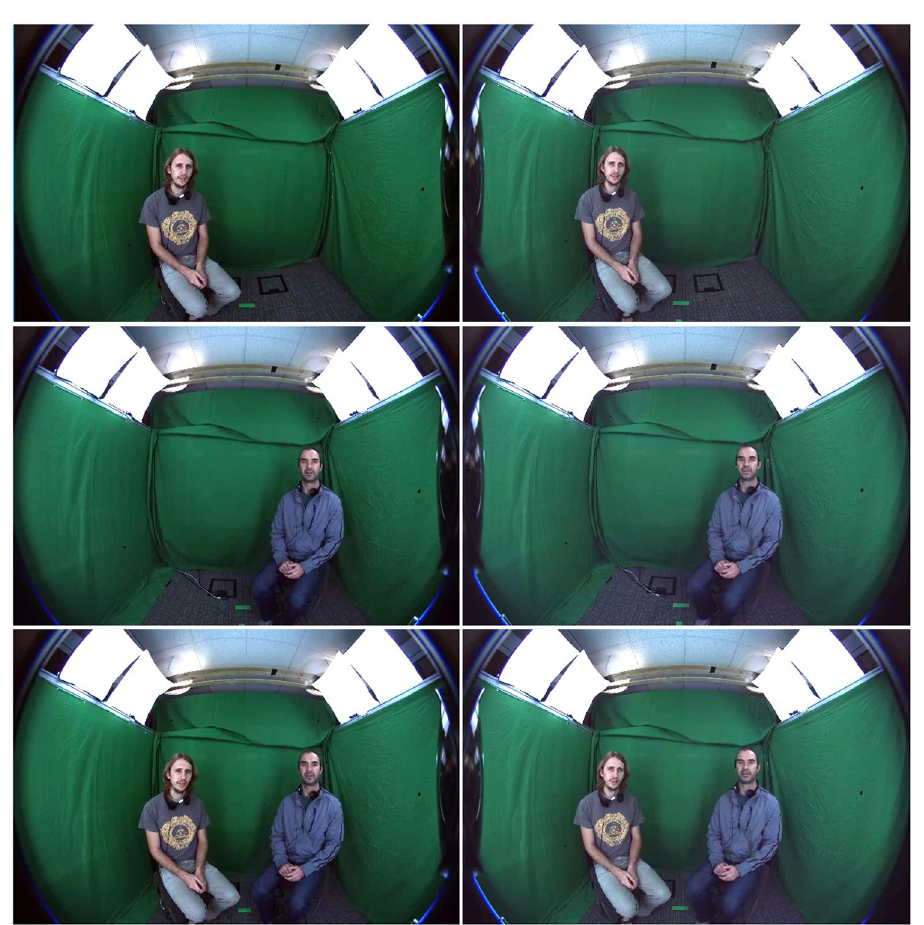
Figure 4. Recorded Footage. Screen shoots of the right and left-eye images as captured from the camera recording setup. The first and second rows show the two actors that were recorded separately. On the bottom the synthetically stitched scene with the two actors as the participants experienced